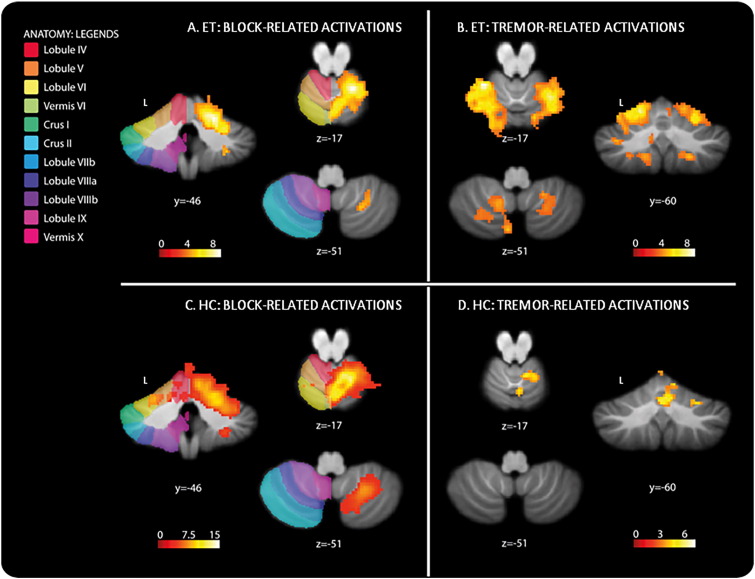
Increased cerebellar activations in essential tremor patients related to the within group comparisons for the block contrast, p < 0.001 (uncorrected, extent k = 20) (1A: block-related activations), and activations related to the within group comparisons for the r-EMG contrast, p < 0.001 (uncorrected, extent k = 20) (1B: tremor-related activations) and increased cerebellar activations in healthy controls related to the within group comparisons for the block contrast, p < 0.001 (uncorrected, extent k = 20) (2A: block-related activations), and activations related to the within group comparisons for the r-EMG contrast, p < 0.001 (uncorrected, extent k = 20) (2B: tremor-related activations). Results are projected on the SUIT-template (Diedrichsen, 2006). The color coded bars at the bottom of the figure indicate SPM T-map intensities. The z-coordinates indicate the position of the transversal planes relative to the anterior commissure–posterior commisure plane. L: left hemisphere. (For interpretation of the references to color in this figure legend, the reader is referred to the web version of this article.)